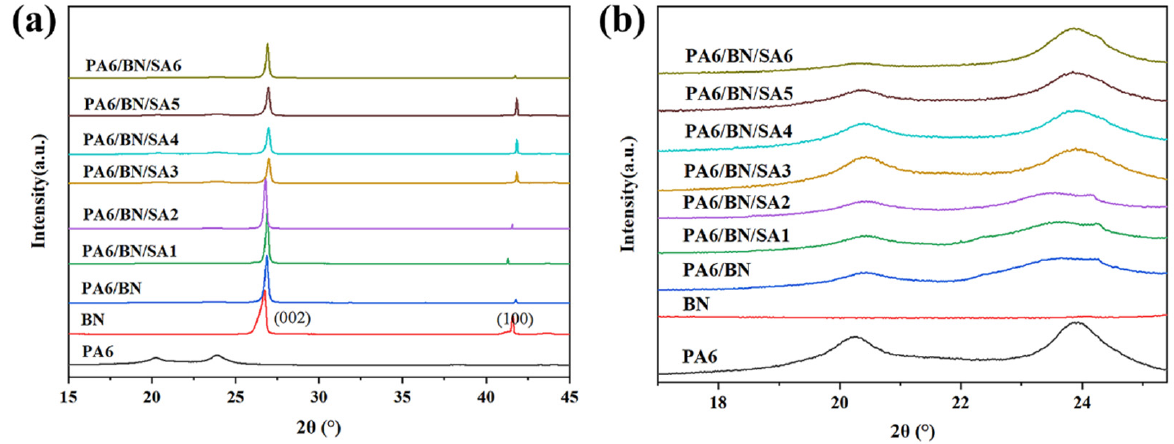
Figure 3. ( a ) XRD patterns of samples and ( b ) a zoomed area of the patterns. Table 1. Ratio of intensity of (002) and (100) planes of BN in composites. SA Content (phr) 0